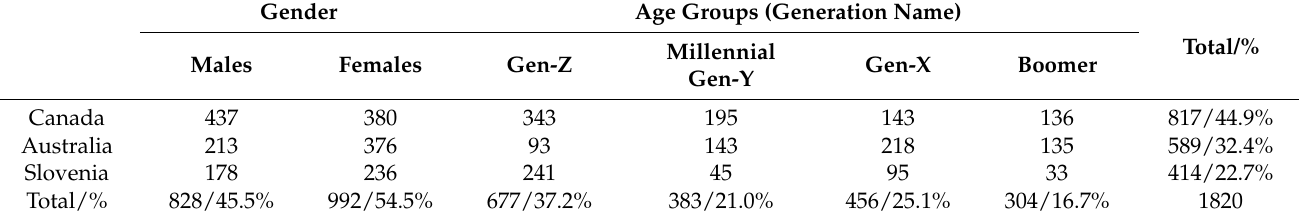
Table 1. Demographic